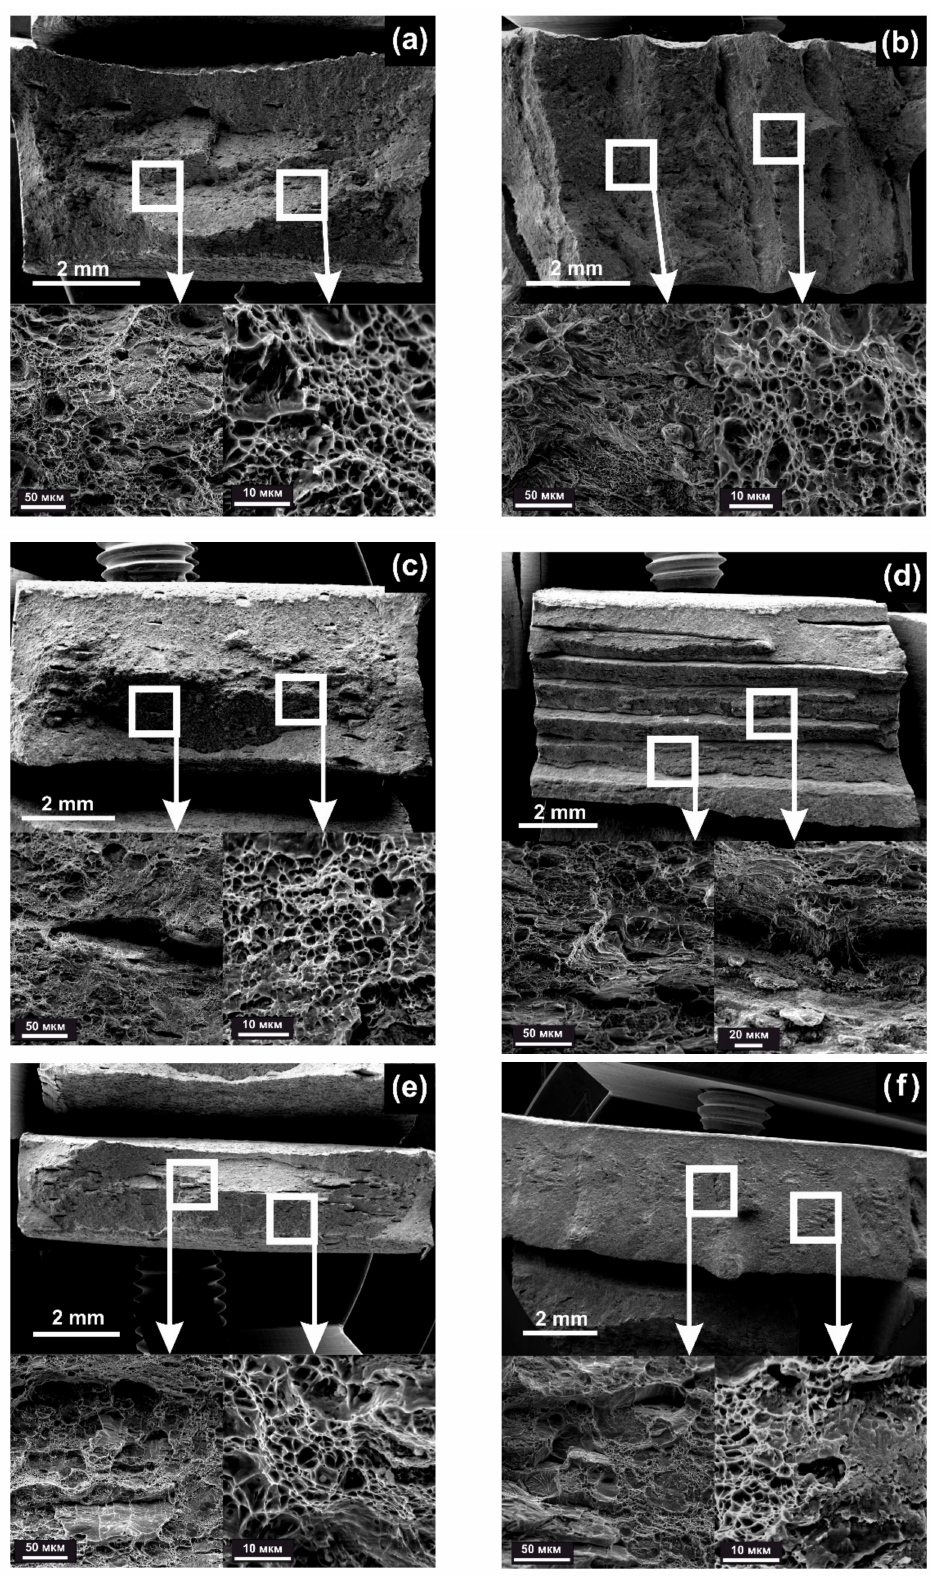
Figure 6. Fractograms of fractures after cold rolling and different degrees of deformation compression: ( a ) 50% (X orientation); ( b ) 50% (Z orientation); ( c ) 60% (X orientation); ( d ) 60% (Z orientation); ( e ) 70% (X orientation); ( f ) 70% (Z